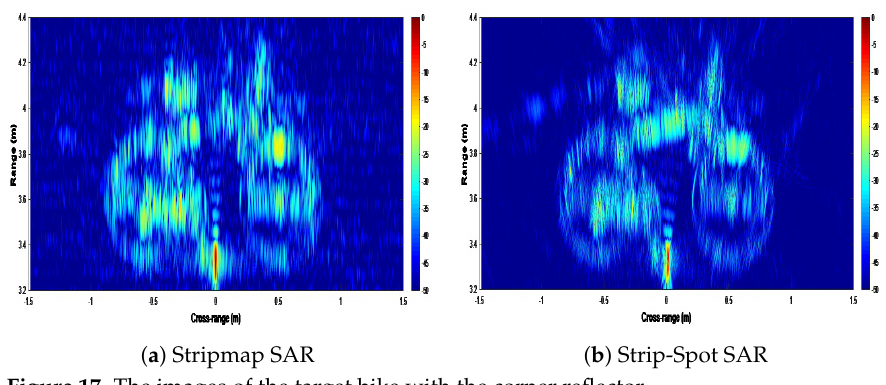
Figure 17. The images of the target bike with the corner reflector.